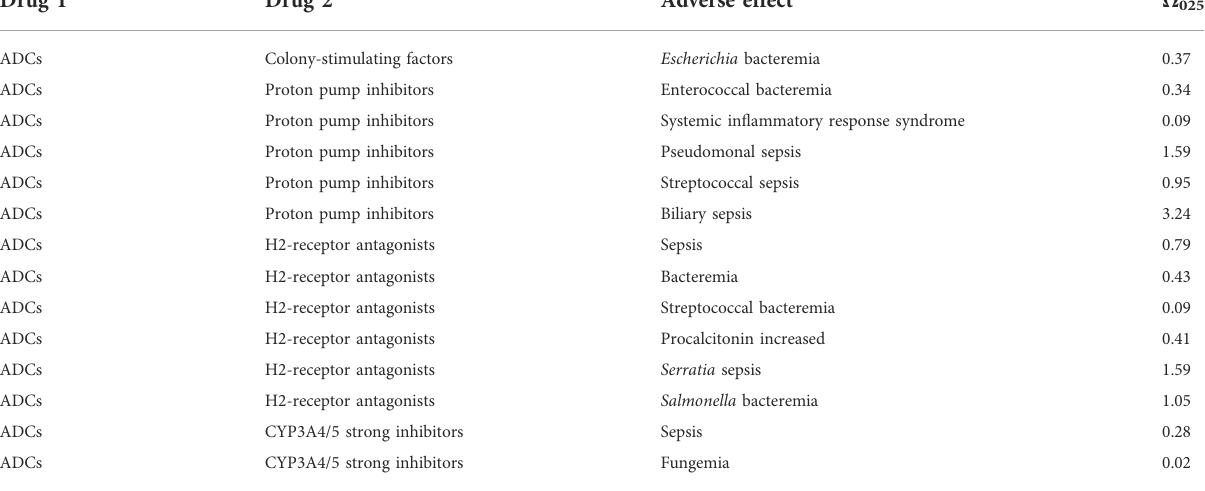
TABLE 9 Drug – drug interaction analysis for ADCs and other